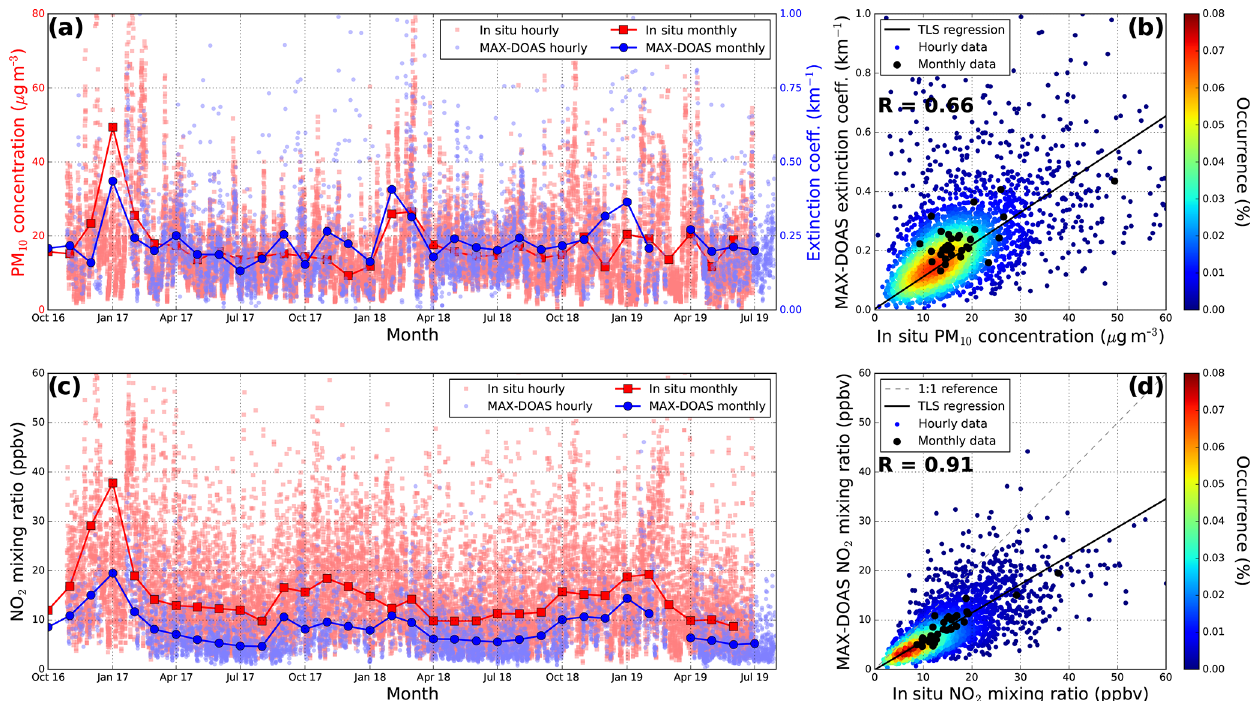
Figure 7. (a) Time series of surface aerosol optical extinction coefficients ε surf at 360nm retrieved from MAX-DOAS observations (blue curve) and PM 10 concentrations measured by the air quality monitoring station (red curve). (b) Scatterplot of ε surf against PM 10 concentra- tions. (c) Time series of surface NO 2 mixing ratios measured by the MAX-DOAS (blue curve) and the air quality monitoring station (red curve). (d) Scatterplot of the NO 2 mixing rations measured by the MAX-DOAS against the air quality monitoring station measurements. Correlation coefficient and total least squares regression lines are calculated based on monthly averaged data.